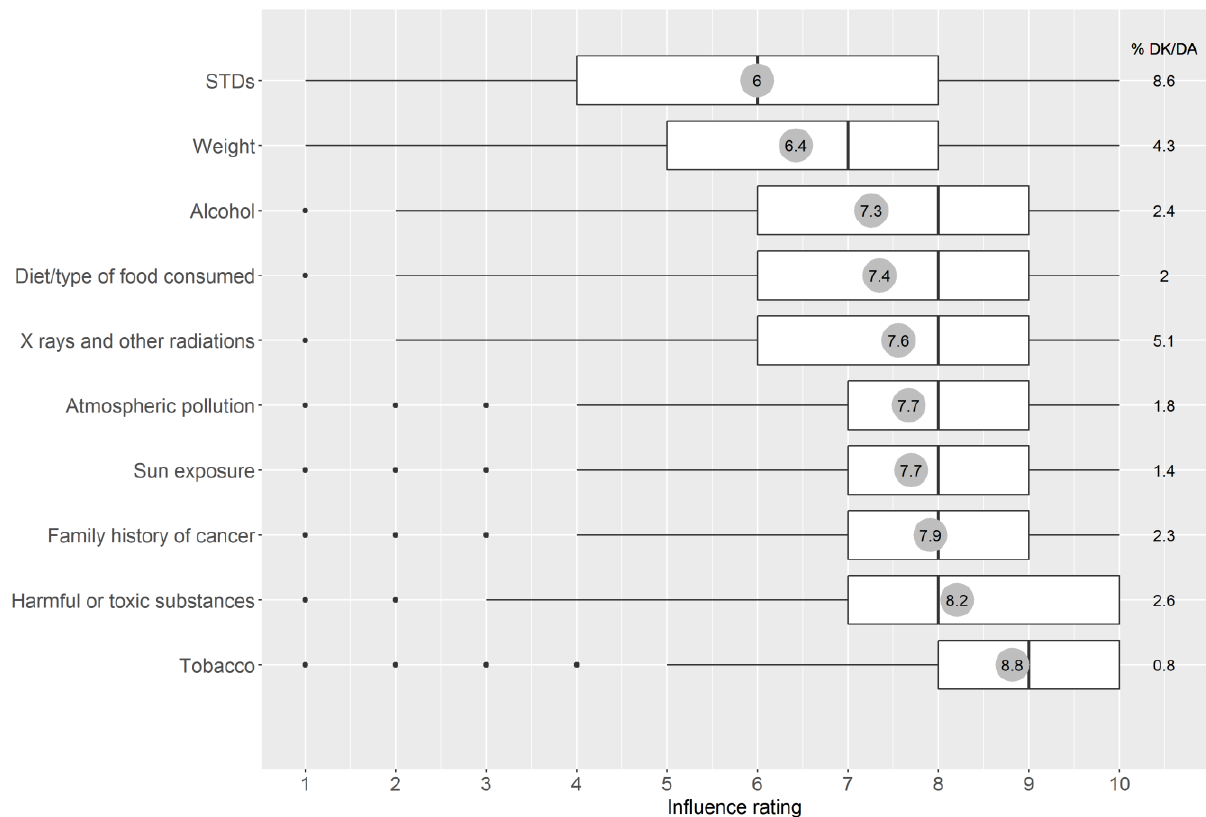
Figure 1. Influence ratings from 1 (has no influence) to 10 (lots of influence) for each of the 10 factors regarding its role in the development of cancer. Note: The line that divides each box in two is the median; the dimensions of the box are the interquartile range; the value in the grey circle is the mean. DK/DA = Percentage respondents indicating “I don’t know” or who do not answer. STDs = sexually transmitted diseases.